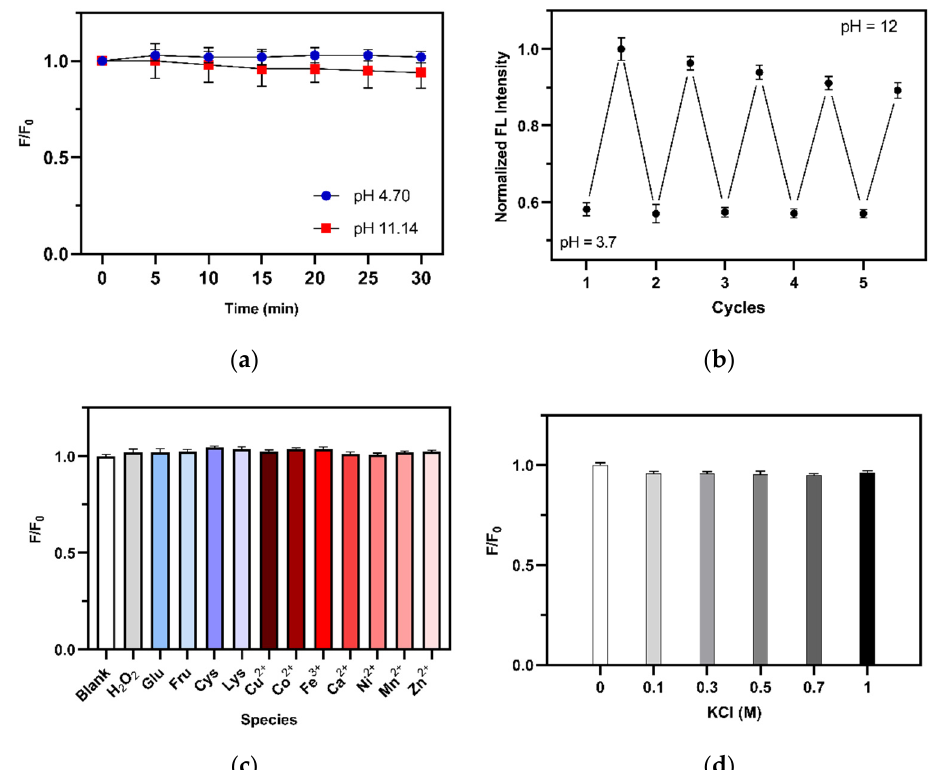
Figure 5. ( a ) Photostability assay of CD F irradiated under visible light (lamp of 23W (220–240 V 50/60 Hz)) for 30 min in pH 4.7 and 11.1; ( b ) pH reversibility study of CD F between pH 3.7 and 12.1; ( c ) Various fluorescence intensity of the CD F solution with various interferent species. H 2 O 2 (0.5 mM); lysine (Lys) and cysteine (Cys) (1 mM); metallic ions (0.1 mM), Cu 2+ , Co 2+ , Fe 3+ , Ca 2+ , Ni 2+ , Mn 2+ , Zn 2+ ; fructose (Fru) and glucose (Glu) (5 mM); ( d ) Ionic strength effect study on CD F using solutions with different concentrations of KCl (0, 0.1, 0.3, 0.5, 0.7, 1 M).